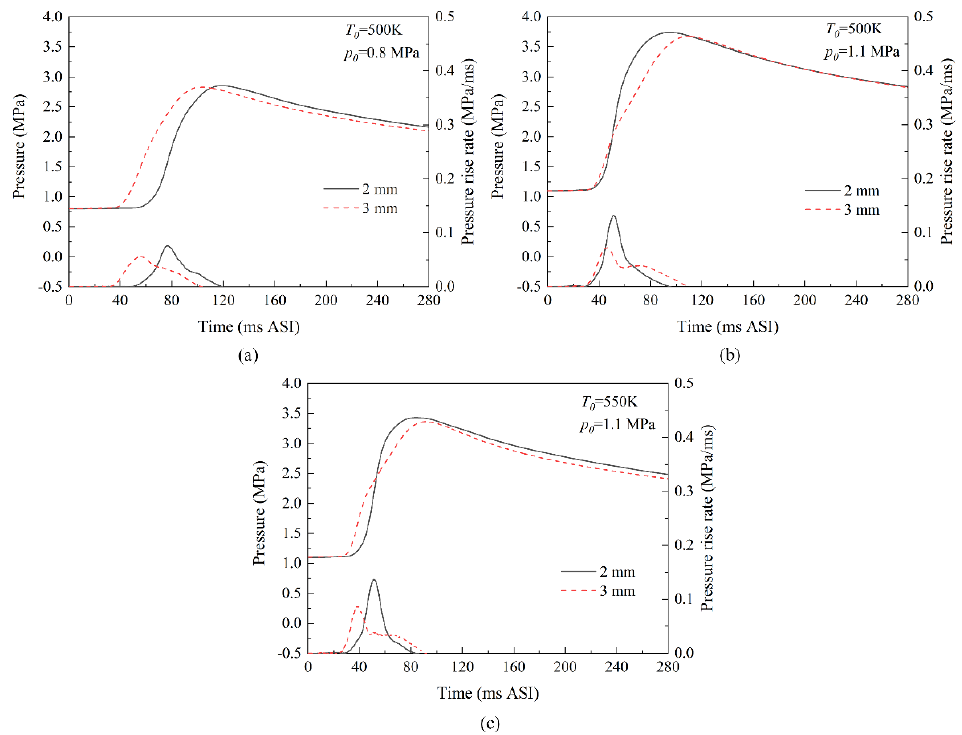
Figure 15. Pressures and pressure rise rates traces in the main chamber for different pre-chamber orifice diameters under different initial thermodynamic orifice diameters under different initial thermodynamic parameters.